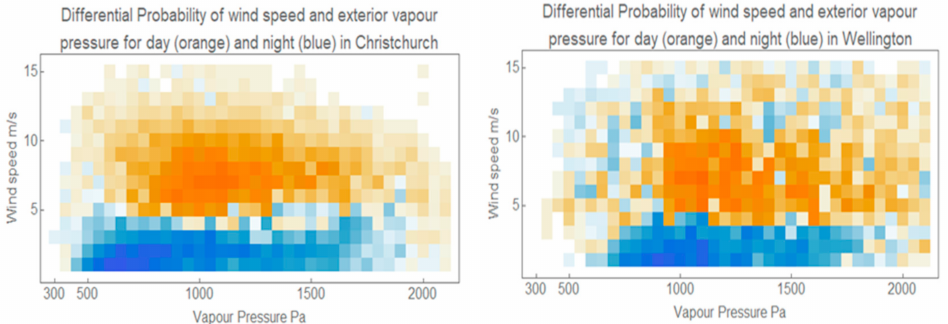
Figure 15. Hourly wind speed in metres per second distribution over the course of a day, aver- aged for July to September. Darker colours represent a higher count in the respective time/wind speed